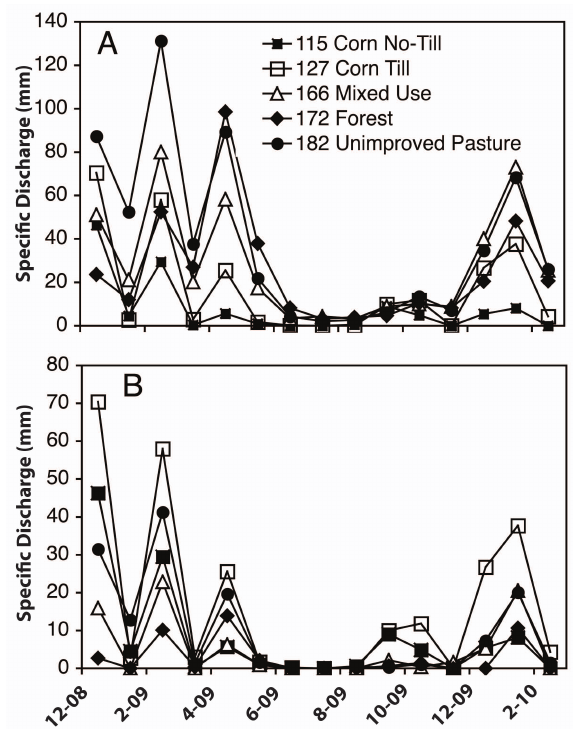
Fig. 2. Specific discharge (mm) by month for (A) total flow and (B) stormflow from December 2008–February 2010 for NAEW wa- tersheds.